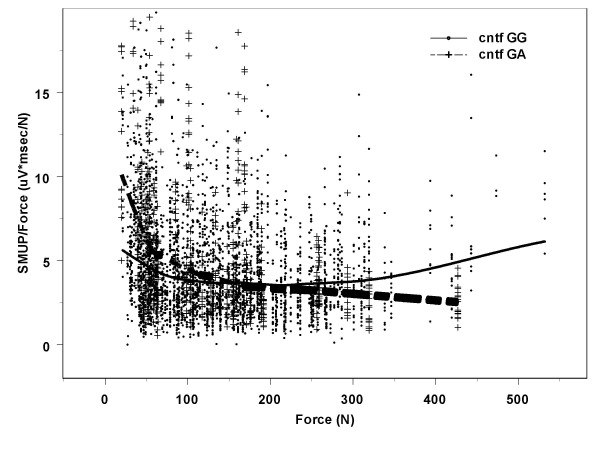
Relationship between knee extension force and motor unit size per unit force (SMUP area/force) for CNTF GG and GA genotypes. Data represent individual measurements with a loess regression line for each genotype. Statistical analyses are given in Table 3.